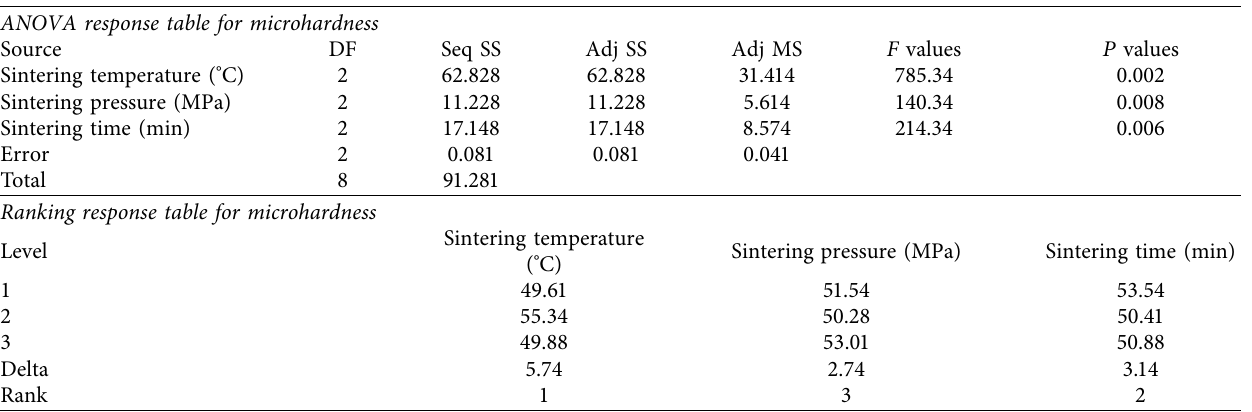
Table 3: ANOVA analysis for the mean of